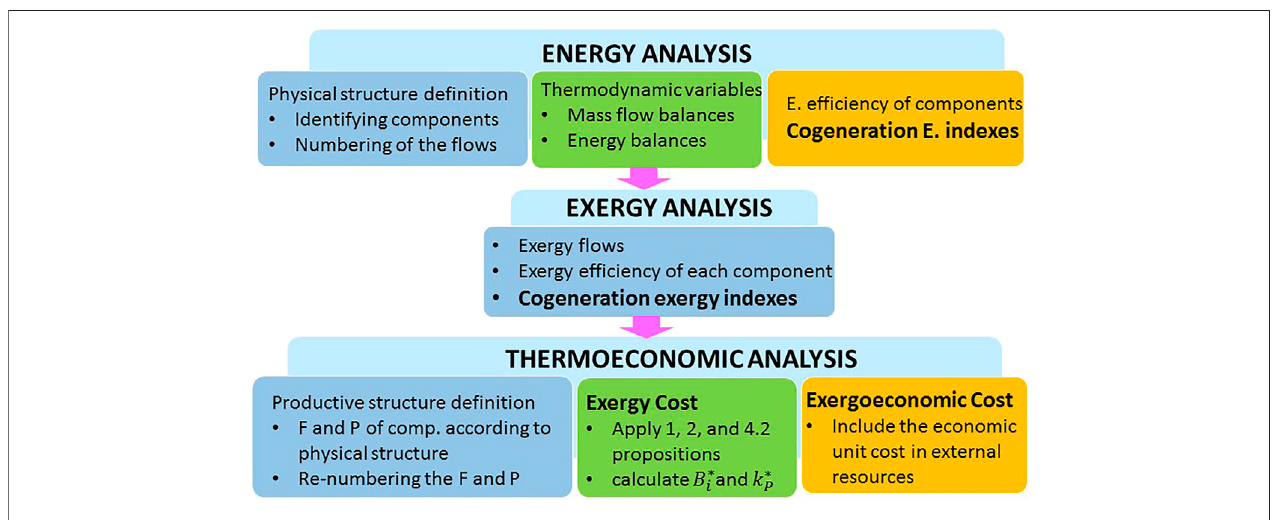
FIGURE 1 | Flow chart of the